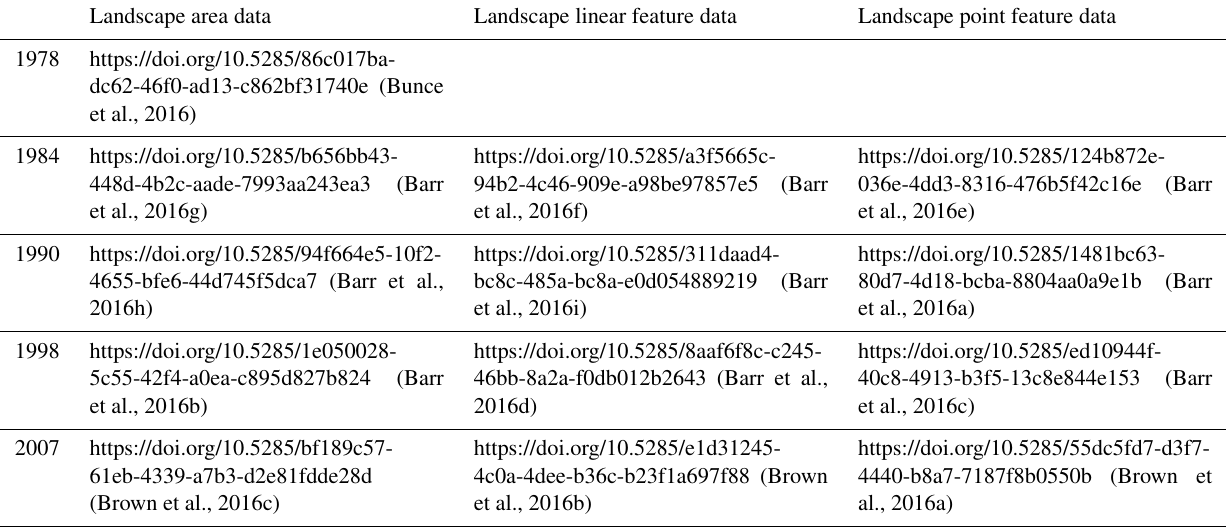
Table 6. Table of DOIs for landscape element data. Landscape area data Landscape linear feature data Landscape point feature